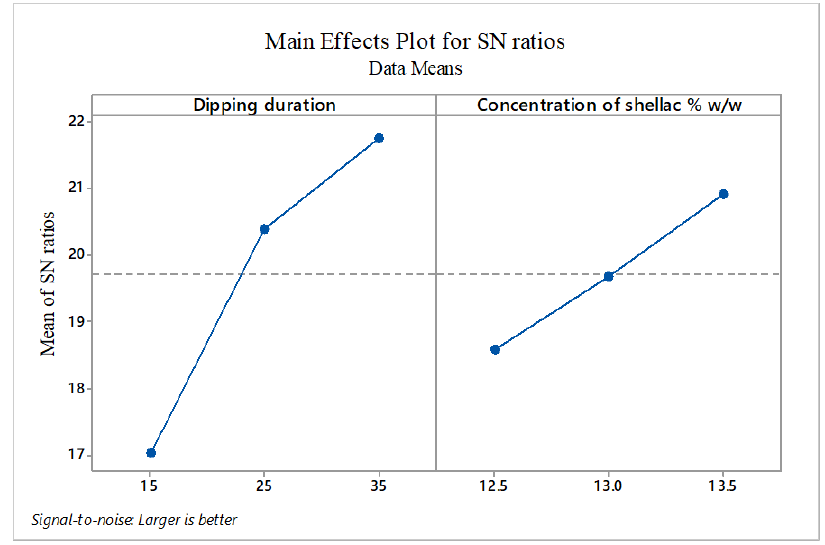
Figure 6. Coating parameters effect on bonding